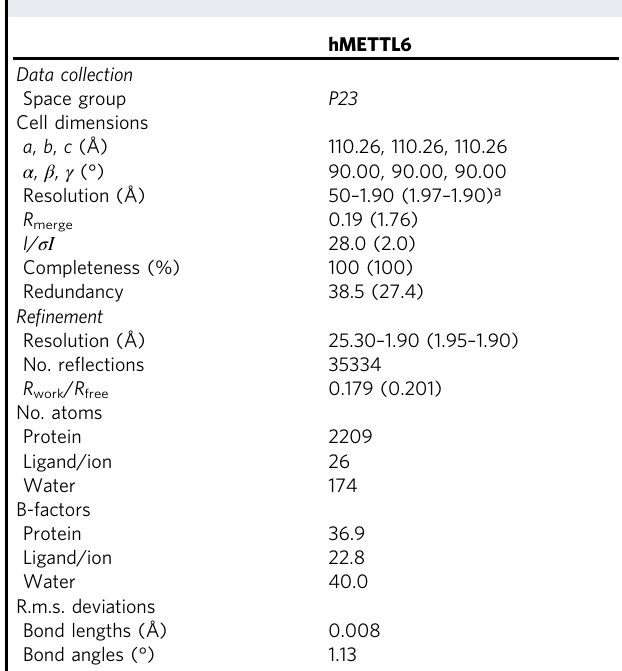
Table 1 Data collection and re fi nement